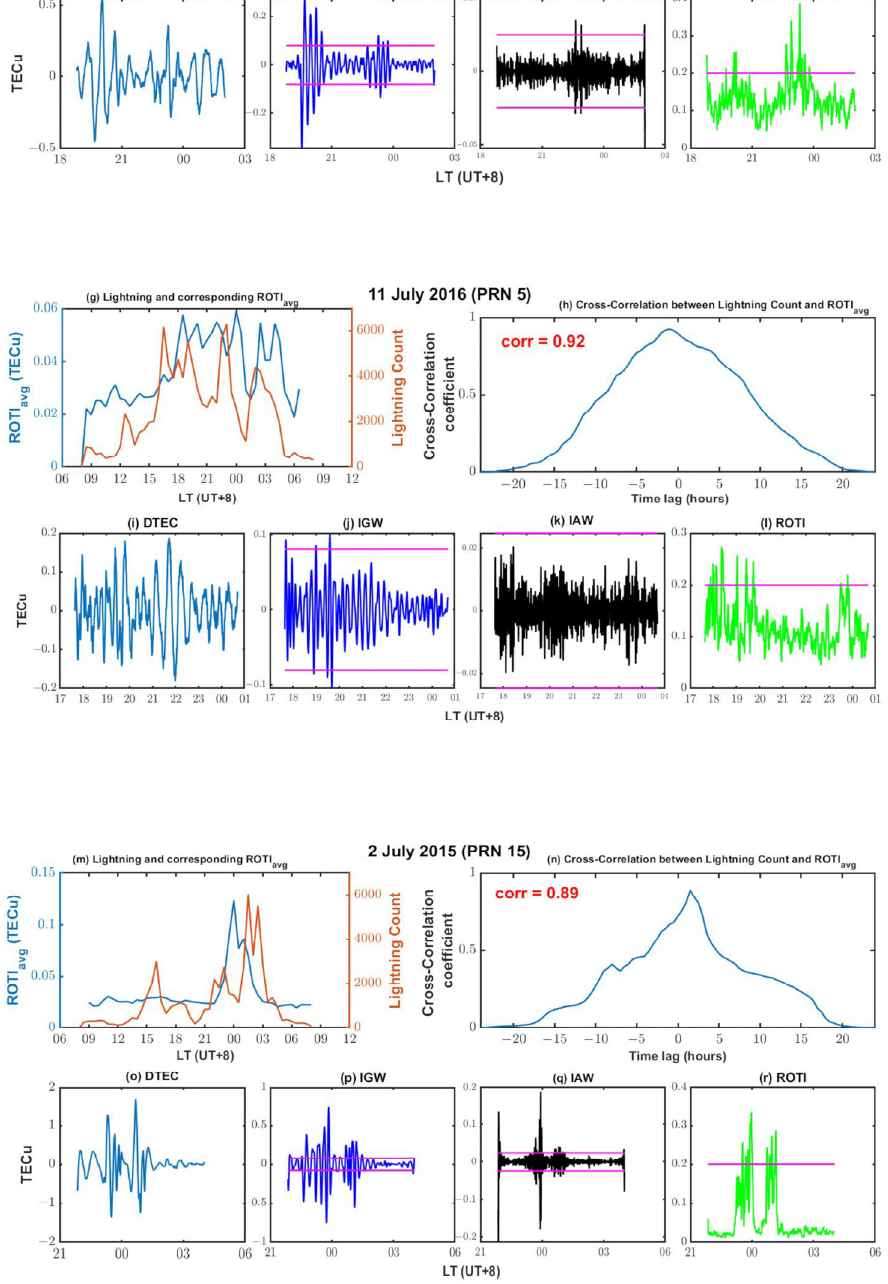
Figure 4. Some selected days (9 August 2015, 11 July 2016, 2 July 2015) where lightning was predominantly in the evening (18–06 local time) and its cross-correlation with ROTI avg ( top rows of each day ). The associated ionospheric disturbances indicated by DTEC, IGW, IAW, and ROTI ( bottom rows of each day ) by satellites that passed at the time of lightning activity. The magenta lines show the threshold of ±0.08 TECu, ±0.025 TECu and 0.2 TECu for IGW, IAW and ROTI respectively.